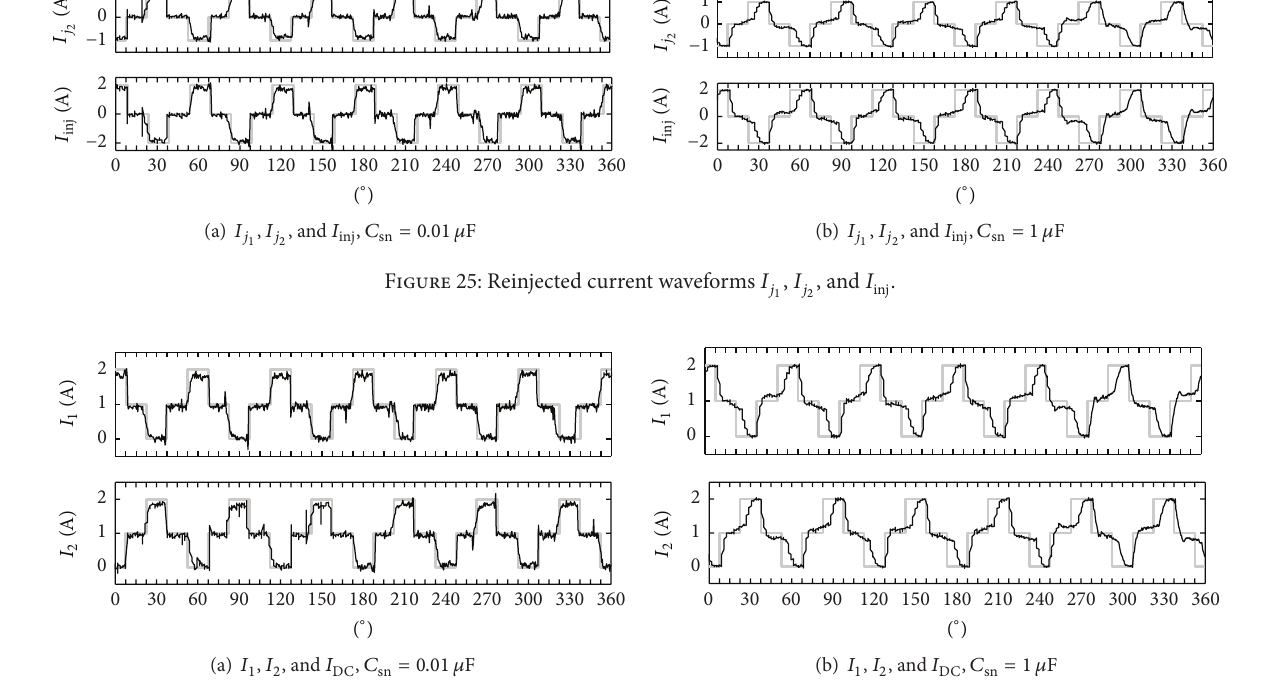
Figure 26: Experimental DC bus currents 𝐼 1 , 𝐼 2 , and 𝐼 DC .